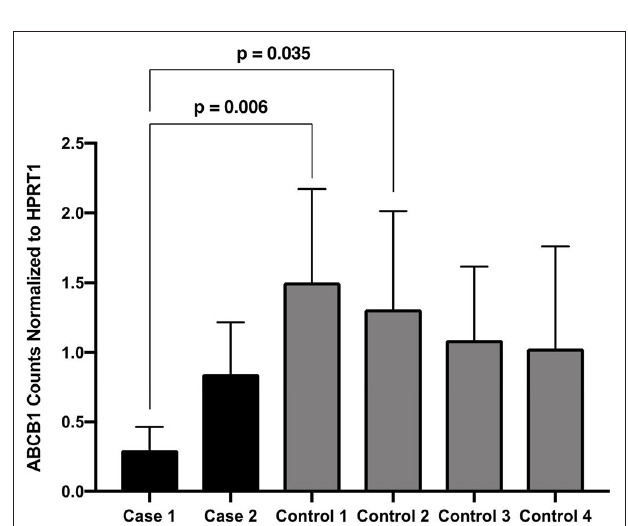
FIGURE 4 | ABCB1 Counts Normalized to HPRT1 . Expression of ABCB1 normalized to HPRT1 for the two patients of interest and four disease controls, pooled from three assays performed in duplicate. Expression is quantified as the number of droplets containing ABCB1 amplicons in the ddPCR assay. Dunn’s multiple comparison tests significant p -values are